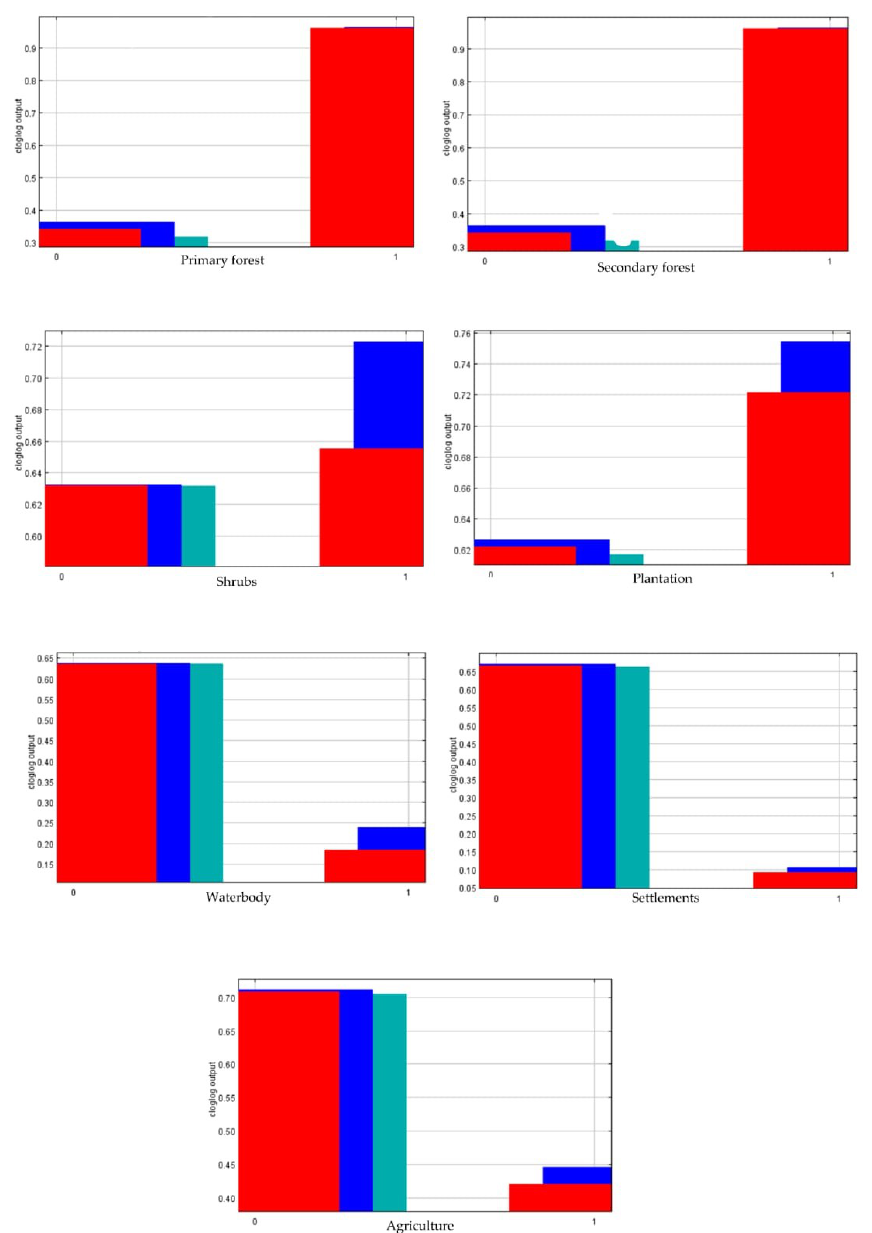
Figure 6. Response curve for the variable land cover without other variables.